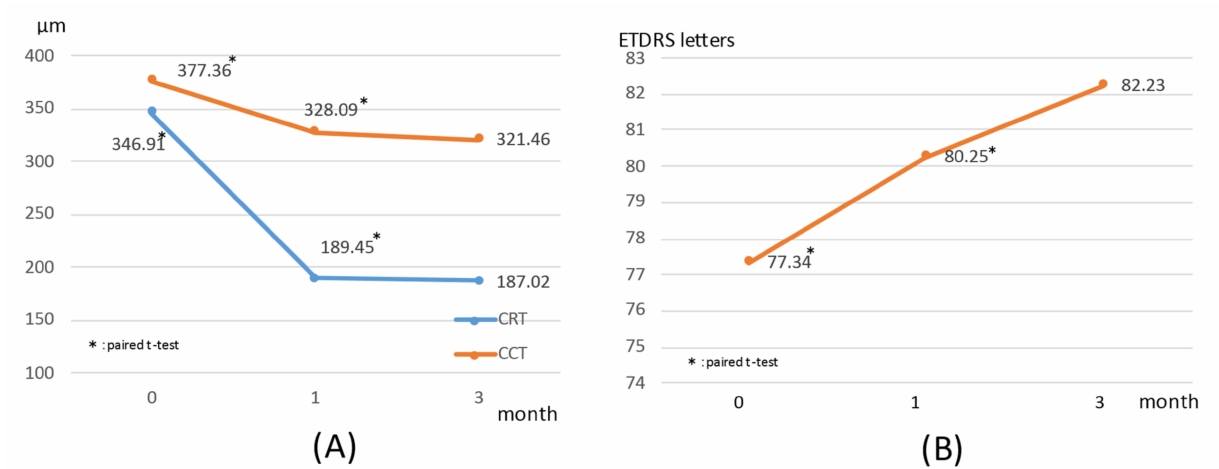
Figure 1. ( A ) Trends in central retinal thickness (CRT: blue), central choroidal thickness (CCT: orange) during the periods starting just before photodynamic therapy until 1 and 3 months after surgery. Reductions at 1 and 3 months after treatment, as compared to the values prior to photodynamic therapy, were significant ( p < 0.0001), but the reductions at 1 and 3 months after treatment did not differ significantly from each other ( p = 0.091, p = 0.368). ( B ) Changes in visual acuity (ETDRS (Early treatment diabetic retinopathy study) letters) before photodynamic therapy and after 1 month and 3 months. Visual acuity showed significant improvement at 1 month and 3 months after treatment, as compared to before photodynamic therapy ( p < 0.0001), but the visual acuity improvements after treatment did not differ significantly between 1 and 3 months post-hPDT ( p =